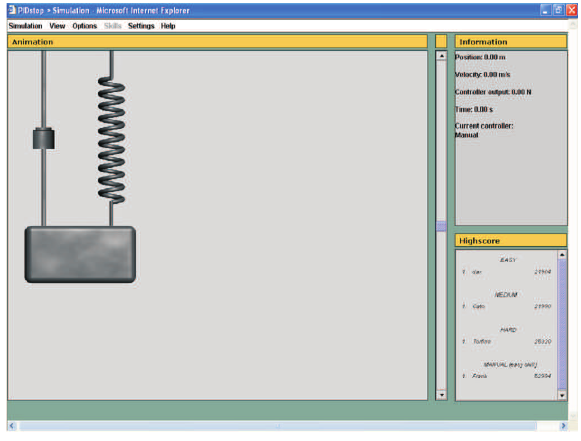
Figure 1: The practice mode.